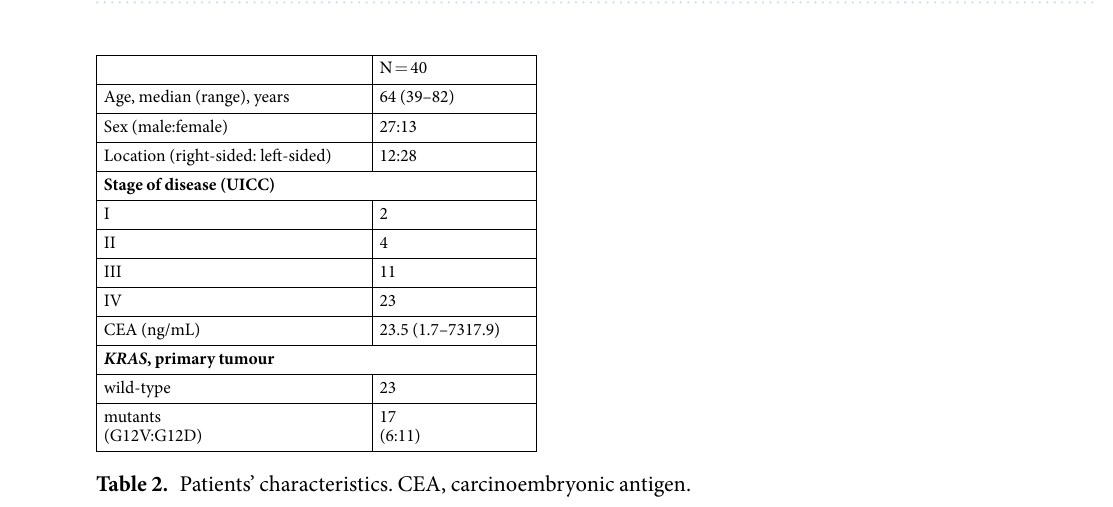
Figure 1. Relationship between fold of enrichment assay and fraction of mutant alleles. ( A ) Fold enrichment of KRAS5 for G12V alleles. ( B ) Fold enrichment of KRAS5 for G12D alleles. ( C ) Fold enrichment of KRAS4 for G12S alleles. ( D ) Fold enrichment of KRAS4 for G12C alleles.